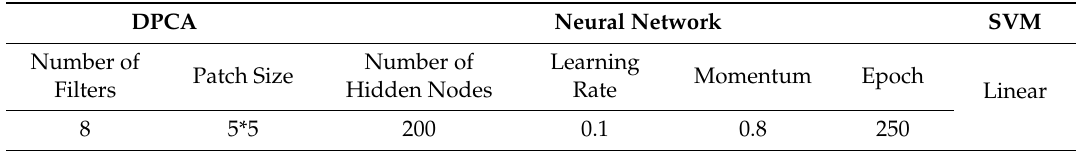
Table 2. The set parameters of the proposed DPCANN.